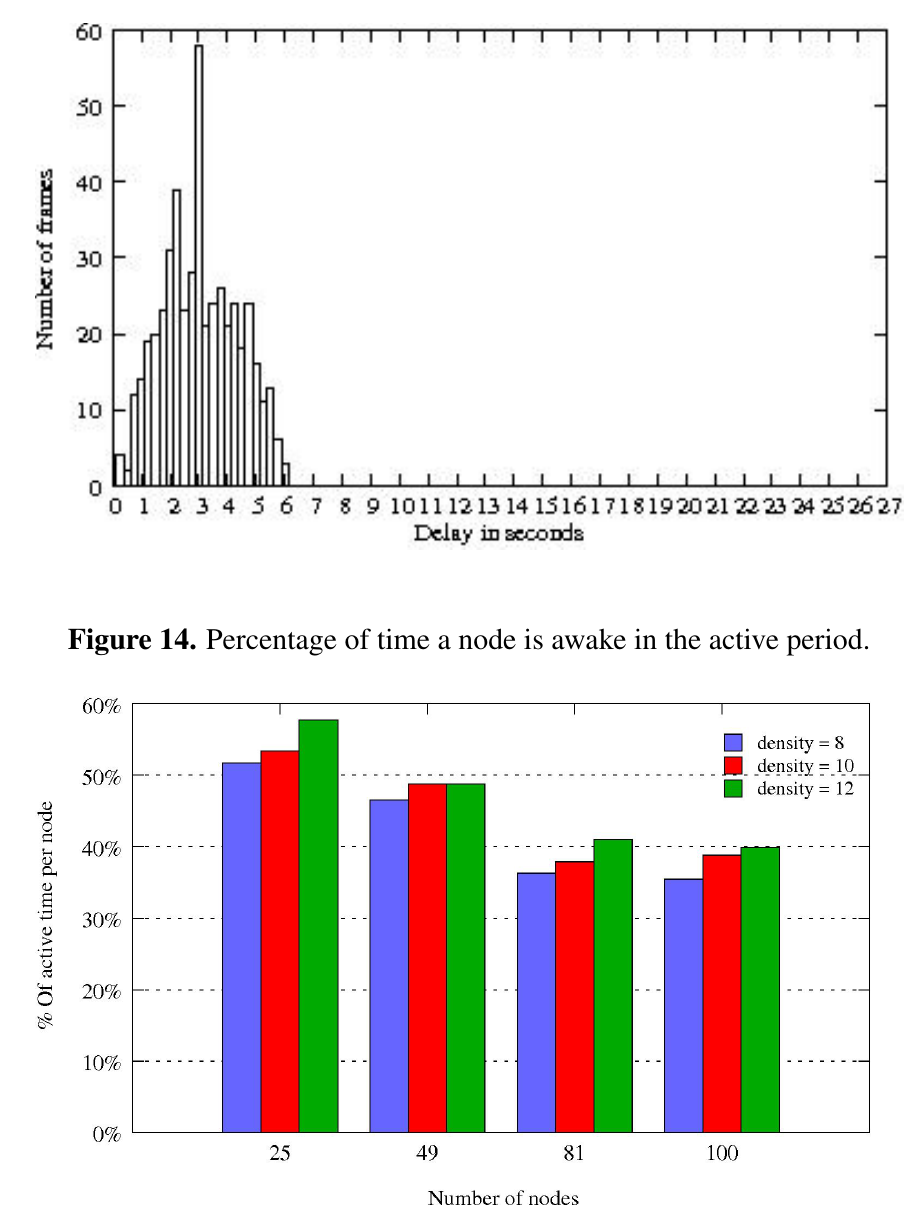
Figure 13. End-to-end delays obtained with a tree-based coloring.